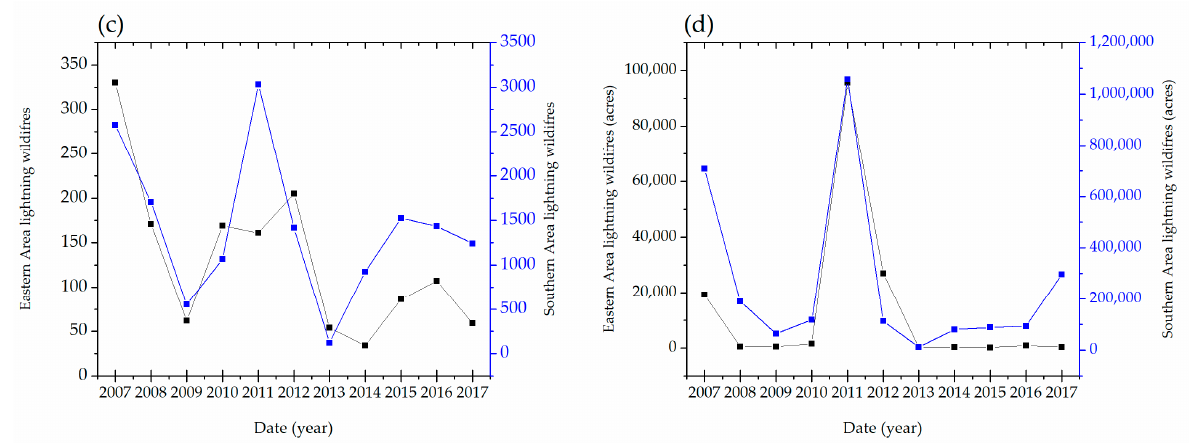
Figure 6. The ( a ) monthly 8-h max O 3 concentrations at the study area; ( b ) temperature abnormalities; ( c ) the number and ( d ) are burnt by wildfires in the Eastern and Southern areas during the period 2007–2017.